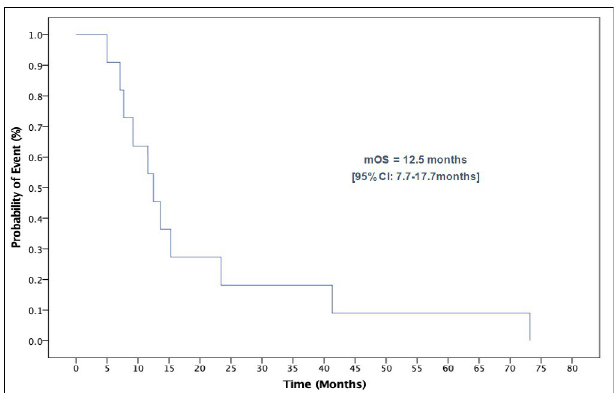
Fig 2. Kaplan Meier curve of overall survival for all patients. Abbreviations: mOS, median overall survival.